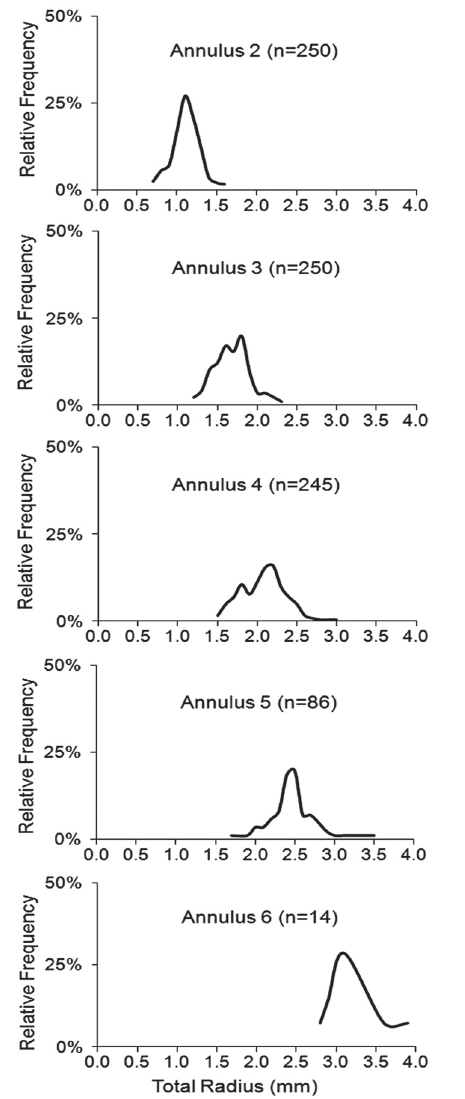
Fig. 2. Frequency distribution of distances between the focus and each annulus identified on the scales of Cichla temensis from the middle rio Negro.